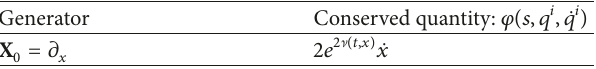
Table 45: Conserved quantity corresponding to the Noether sym- metry.